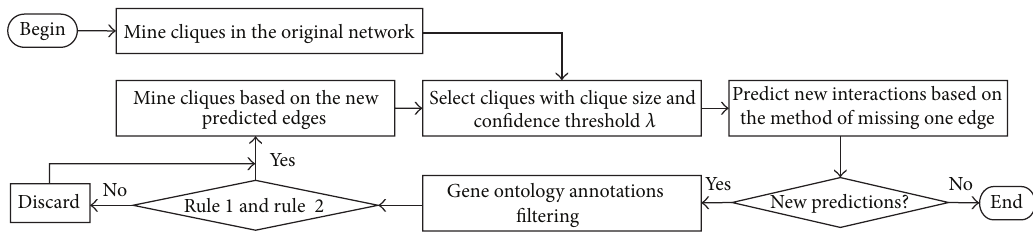
Figure 1: Flowchart of predicting protein interactions in a PPI